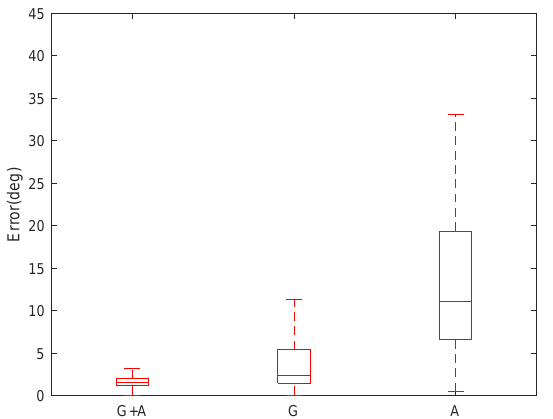
Figure 4. Estimated orientation error | θ err | with gyroscope and accelerometer (values under 99.3 percent coverage are shown in the boxplot figures). “G”, “A” and “G+A” represent estimated results based on gyroscope, accelerometer and gyroscope plus accelerometer